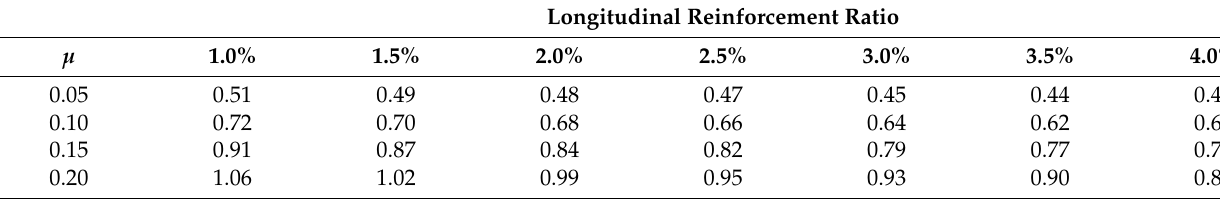
Figure 3. The basic parameters of the column. Table 3. Basic period (T) of the columns.